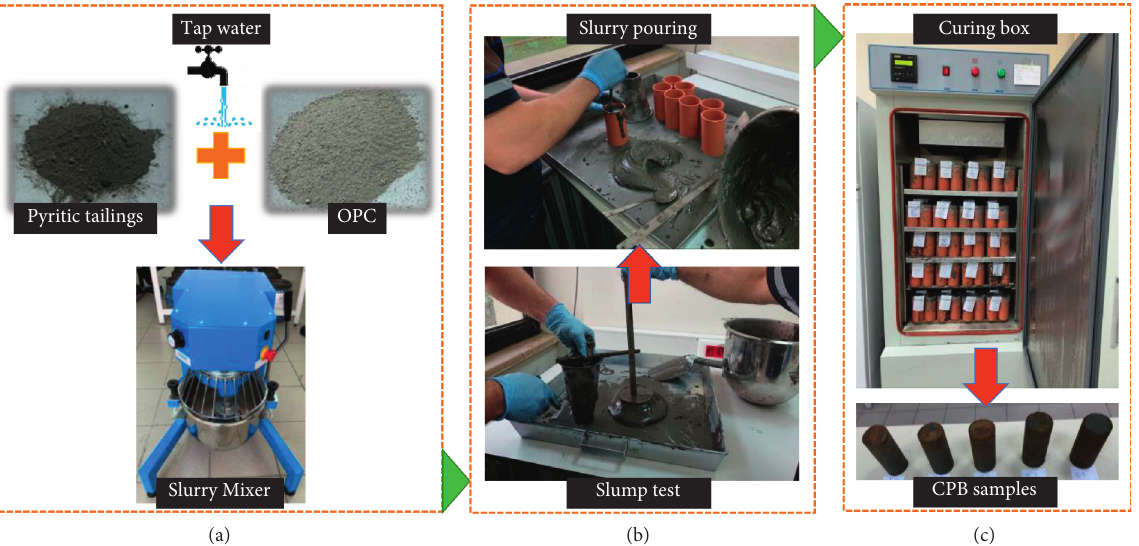
Figure 2: Manufacturing stages of backfill mixtures: (a) blending, (b) slump measurements, and (c)